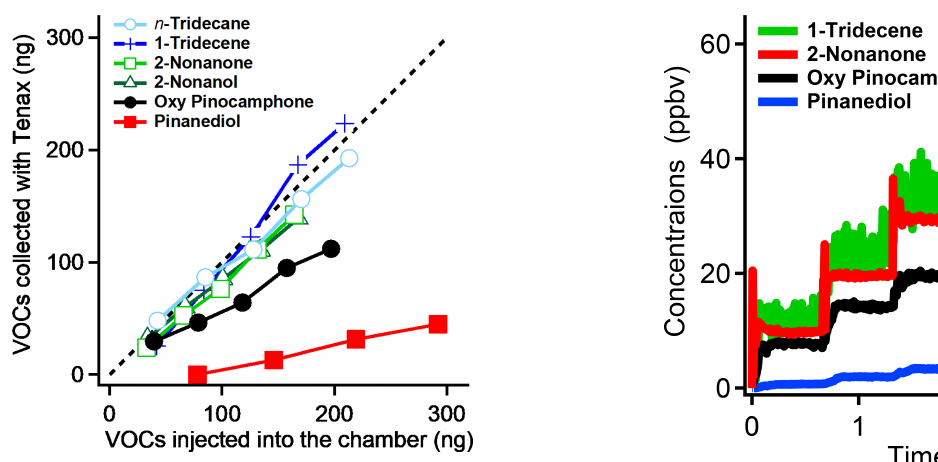
Figure 2. The temporal concentrations of the organics after we injected a series of aliquots of 1-tridencene, 2-nonanone, oxy- pinocamphone, and pinanediol into the chamber in increments of 11ppbv (at 100% injection efficiency). Each injection resulted in a similar increase in all organics. The similar increase indicates that oxy-pinocamphone and pinanediol may have constant wall loss fac- tors in the concentration range studied in this